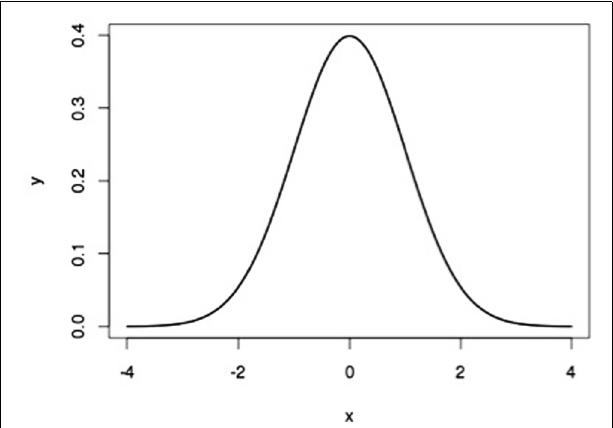
FIGURE 1 |The Gaussian, or “normal,” distribution. X represents the measured variable, andY represents the probability of occurrence of particular values of X .